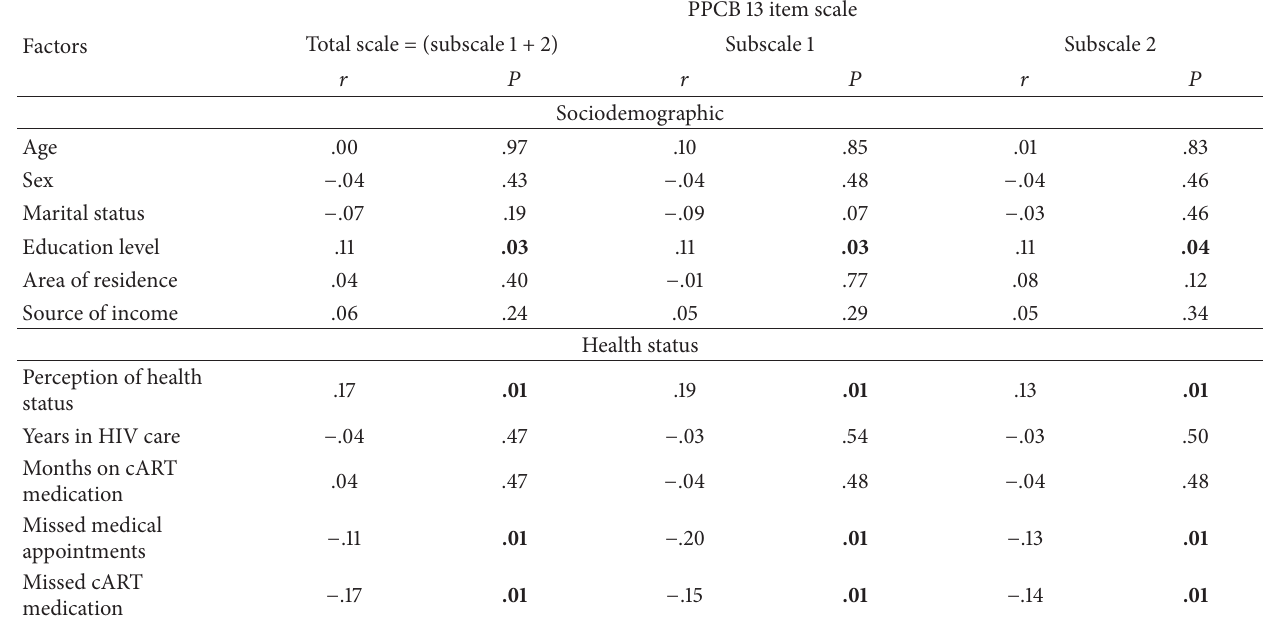
Table 3: Bivariate relationship between PPCB subscales and patient sociodemographic and health characteristics.